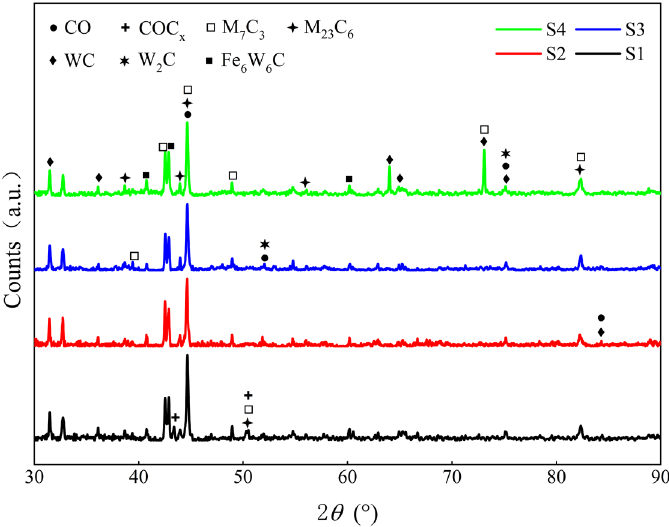
Figure 11. XRD chromatogram of the Stellite 6/WC composite coating of different specimens.